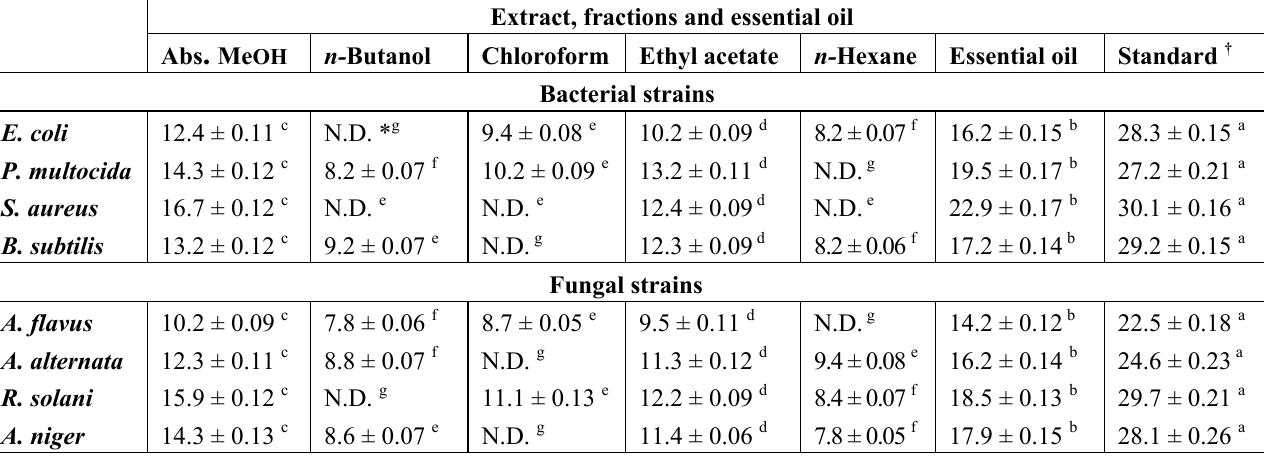
Table 2. Antimicrobial activity in terms of inhibition zone (mm) of M. goodenifolius plant extract, fractions at 10 mg/mL against selected bacterial and fungal strains.